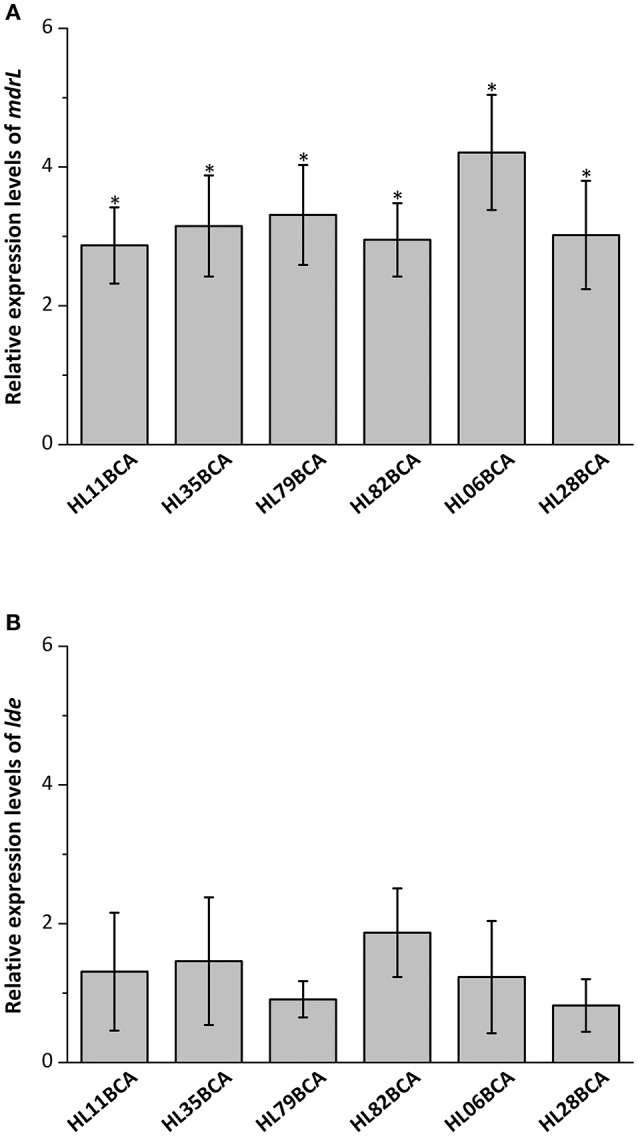
(A) Relative expression levels of mdrL in six BC adapted strains in BHI broth. (B) Relative expression levels of lde in six BC adapted strains in BHI broth. Results are presented as fold changes of the gene tested in the BC adapted strain compared to that in its wild-type strain in BHI broth. Error bars represent the standard deviation of triplicate experiments (n = 3). The asterisk indicates a value statistically different from that of HL06 grown in BHI, with a P-value < 0.05.